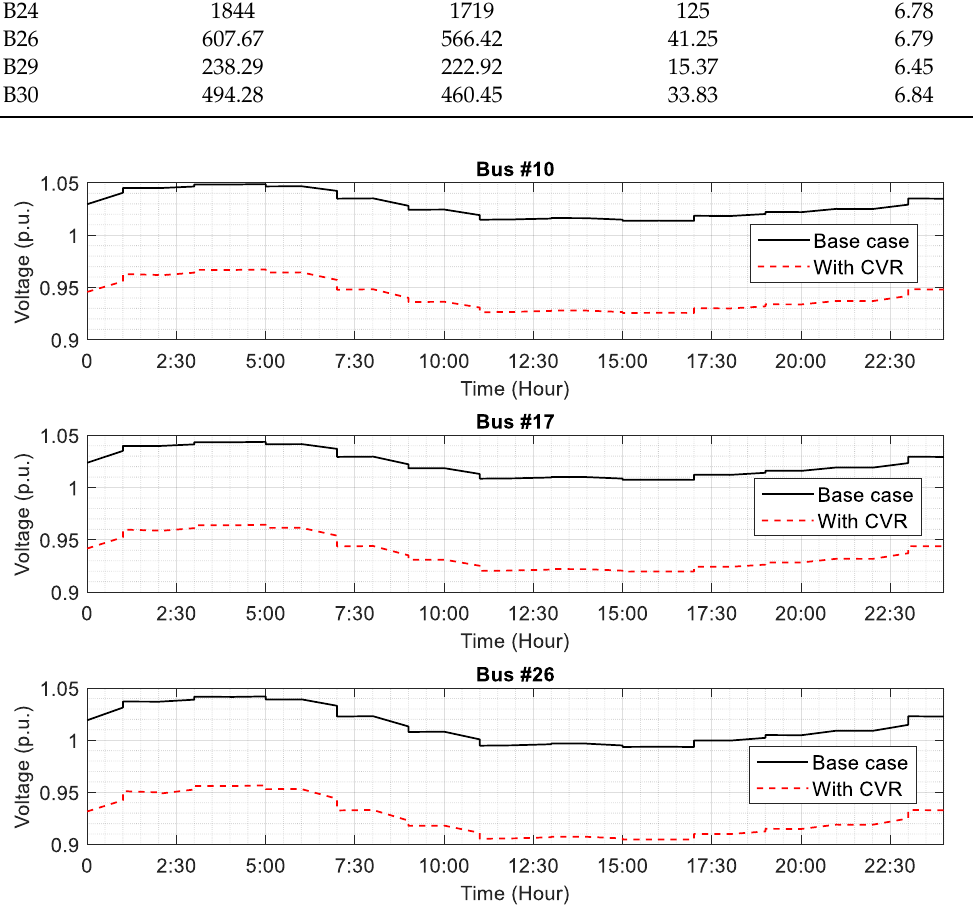
Figure 9. Case III: Voltage vs. time with/without CVR.